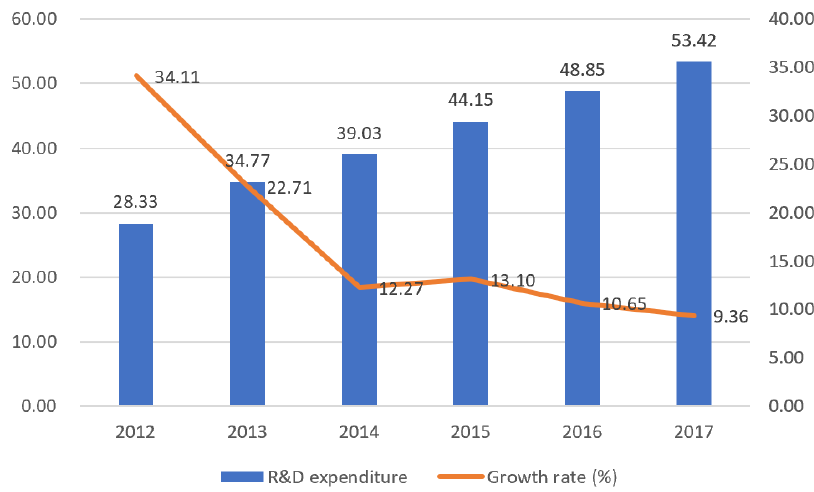
Figure 4. R&D expenditure of the pharmaceutical industry in China (billion yuan). Data resource: China National Bureau of Statistics, http://www.stats.gov.cn.